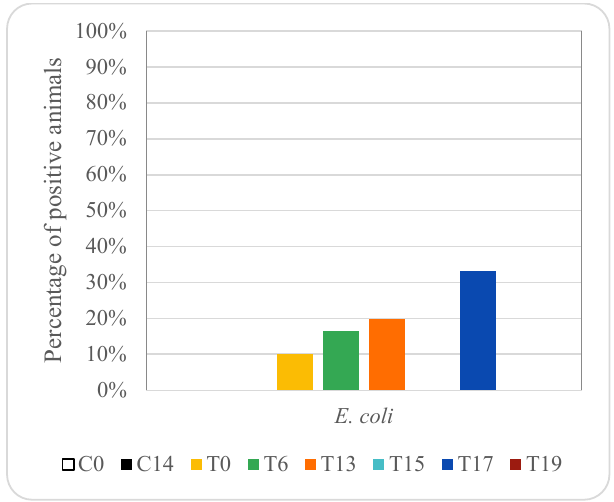
Figure 9. Effect of oxytetracycline treatment on carbapenemase-producing E. coli in pig rectal samples. For group descriptions, C0, C14, T0, T6, T13, T15, T17 and T19: see Table 1.